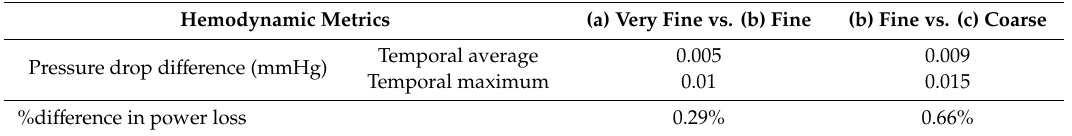
Table 2. Di ff erences in pressure drop and power loss with di ff erent mesh